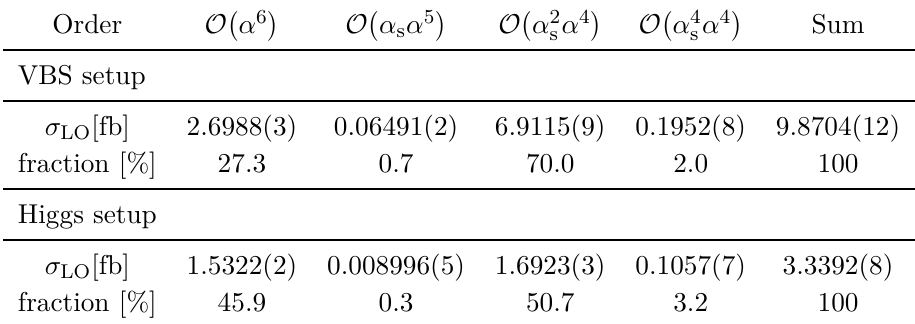
Table 1. LO cross sections and contributions of individual orders (cid:0) (cid:1) α 4 α 4 for pp e + ν e µ − ¯ ν µ jj + X at 13 TeV CM energy at the central scale. No contributions s O → with external bottom quarks are included. Each contribution is given in fb and as fraction relative to the sum of the four contributions in percent. The digits in parentheses indicate integration